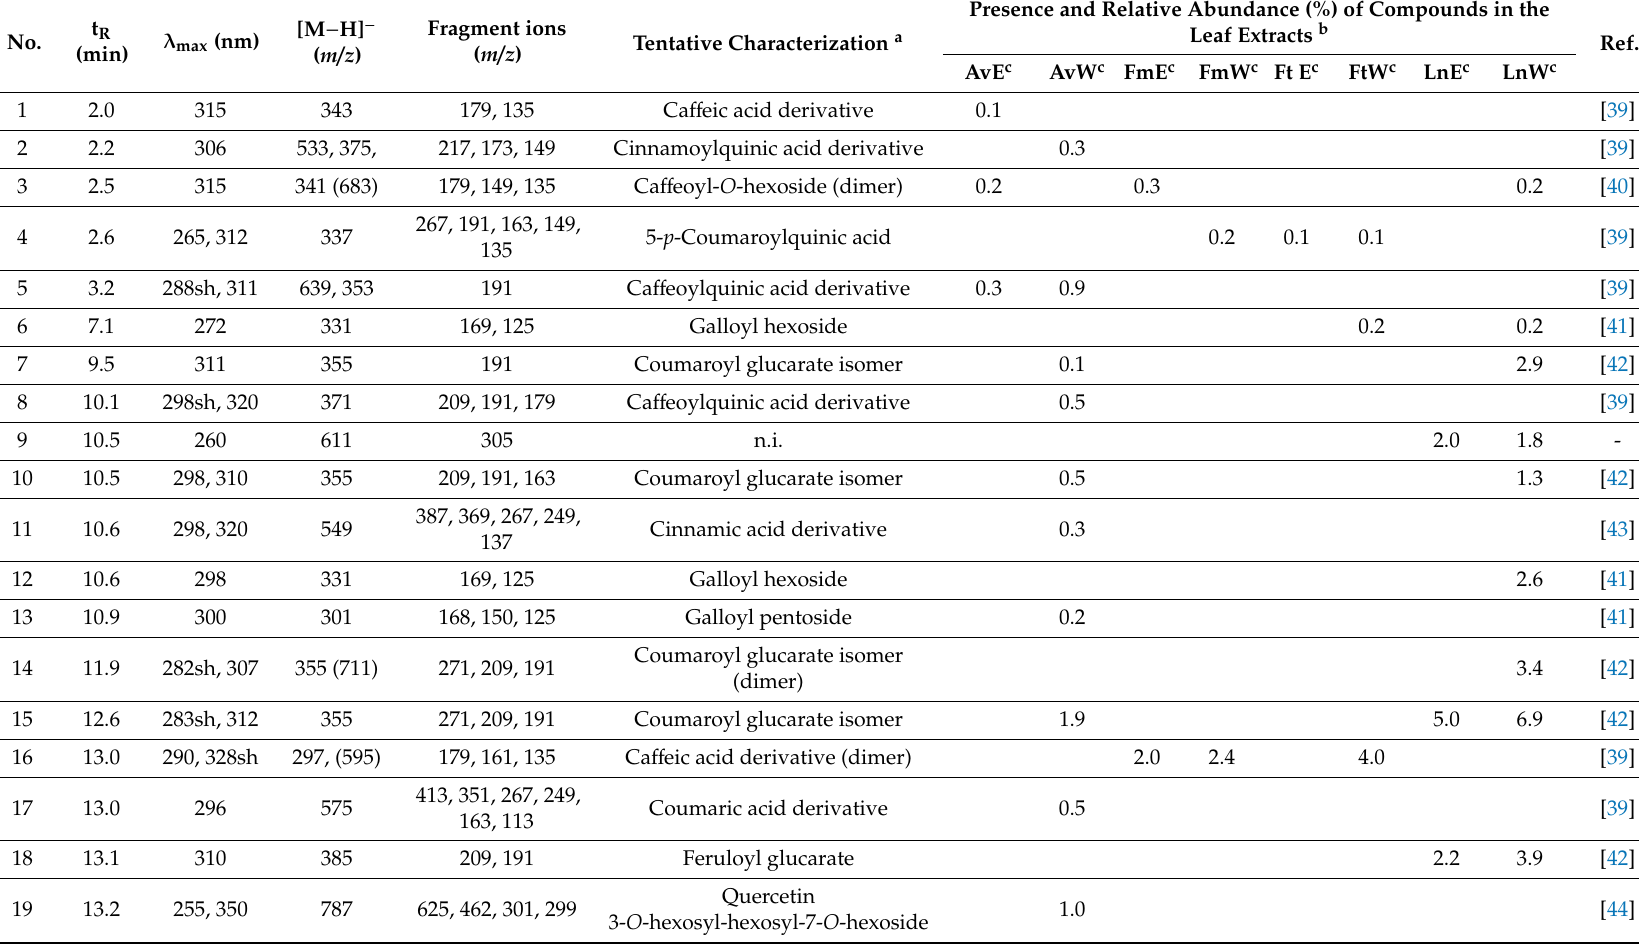
Table 1. LC-MS / MS data and tentative characterization of compounds from Anthyllis vulneraria, Fuchsia magellanica, Fuchsia triphylla and Lysimachia nummularia leaf